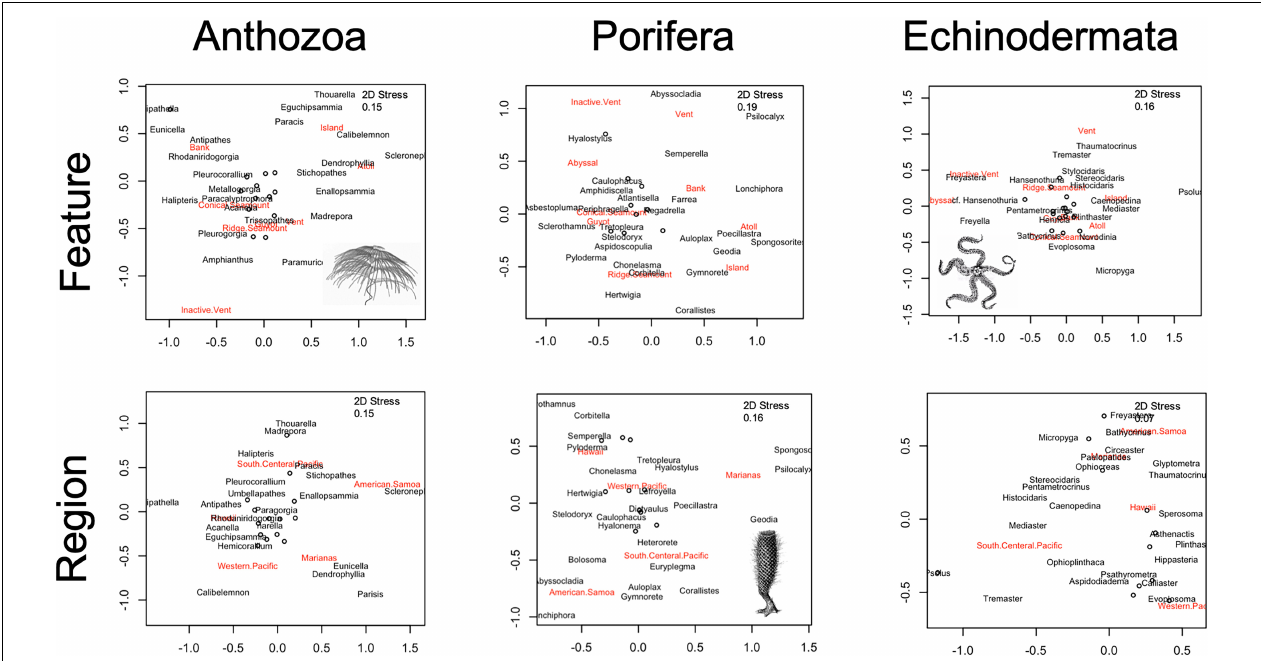
FIGURE 8 | Non-metric multiple dimensional scaling ordination of the Bray–Curtis dissimilarity matrices are displayed, with geologic feature (top panel) and geographic region (bottom panel) groups noted. Taxonomic assemblages are abundances corrected for effort at the genus-level for the highest frequency genera observed ( N = 35 for